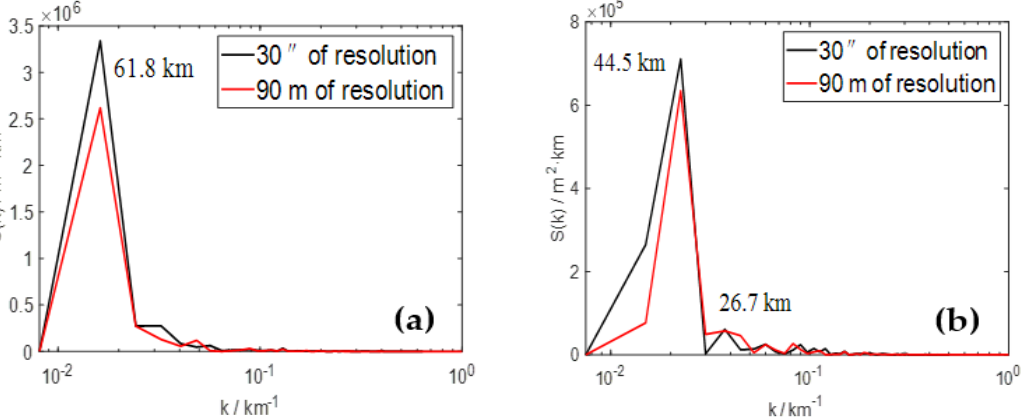
Figure 3. The arithmetic-mean terrain height variance spectra ( a ) in the zonal direction and ( b ) in the meridional direction. Black curve and red curve correspond to 30 ″ resolution and 90 m resolution, respectively.